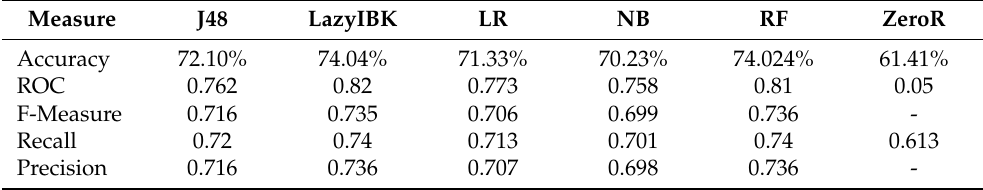
Table 2. Summary of the Performance